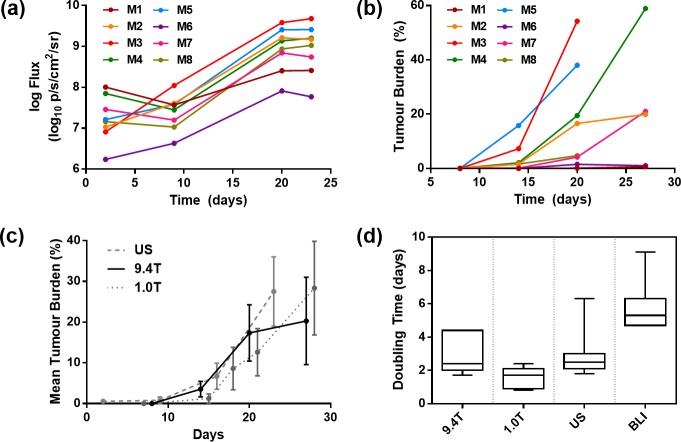
Multimodal assessment of tumour growth: (a) Individual tumour log-growth curves from BLI photon intensity across the whole study. Photon flux increased a hundred-fold between day 9 and day 20 and then plateaued. (b) Assessment of tumour burden, characterised by high-field MRI, in each mouse (M1, M2, M3, etc.). A large spread of tumour volumes was observed over the course of the study. (c) From group-wise plots (mean ± standard deviation) of tumour burden, a good agreement can be seen between US, high-field MRI and low-field MRI estimates of tumour burden. (d) Box-and-whisker plots representing measurements of tumour volume doubling times for the group, across all modalities. ANOVA analysis indicated no significant differences (p > 0.2) between the US, low- and high-field MRI estimates of tumour burden, but a significant overestimation (p < 0.01) for BLI.